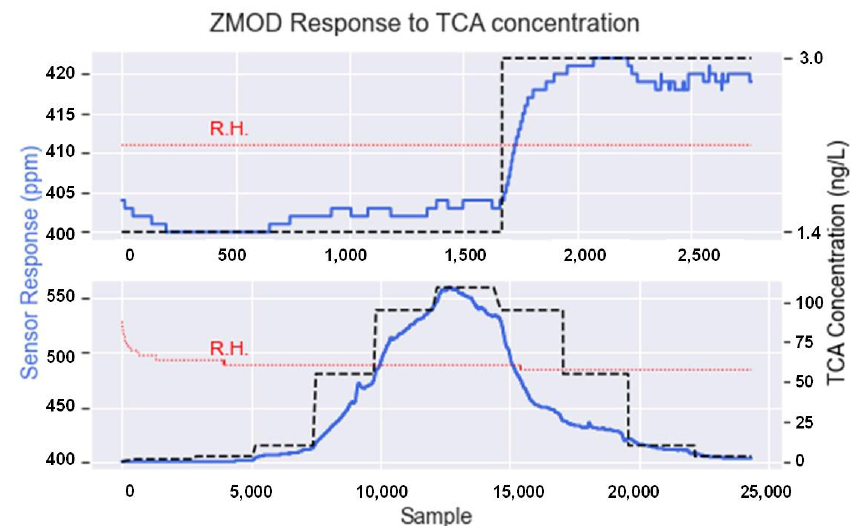
Figure 6. ZMOD4410 response to different TCA concentrations. The black dashed line represents the TCA concentration, the blue line represents the sensor response, and the red dotted lines show that the relative humidity remained constant during the experiment (33% R.H. approx.).